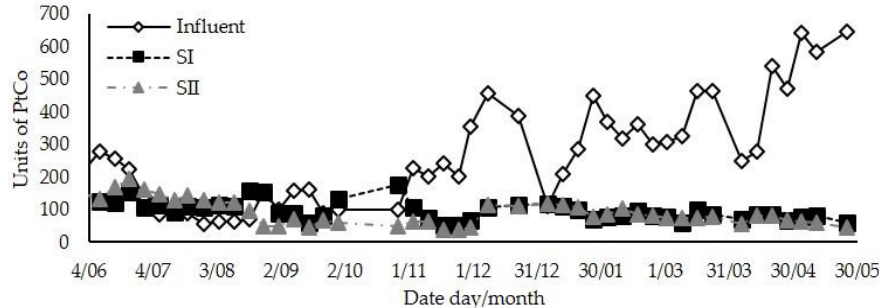
Figure 5 . Behavior of the true color concentration along the study with PS VF wetlands. Figure 5. Behavior of the true color concentration along the study with PS VF